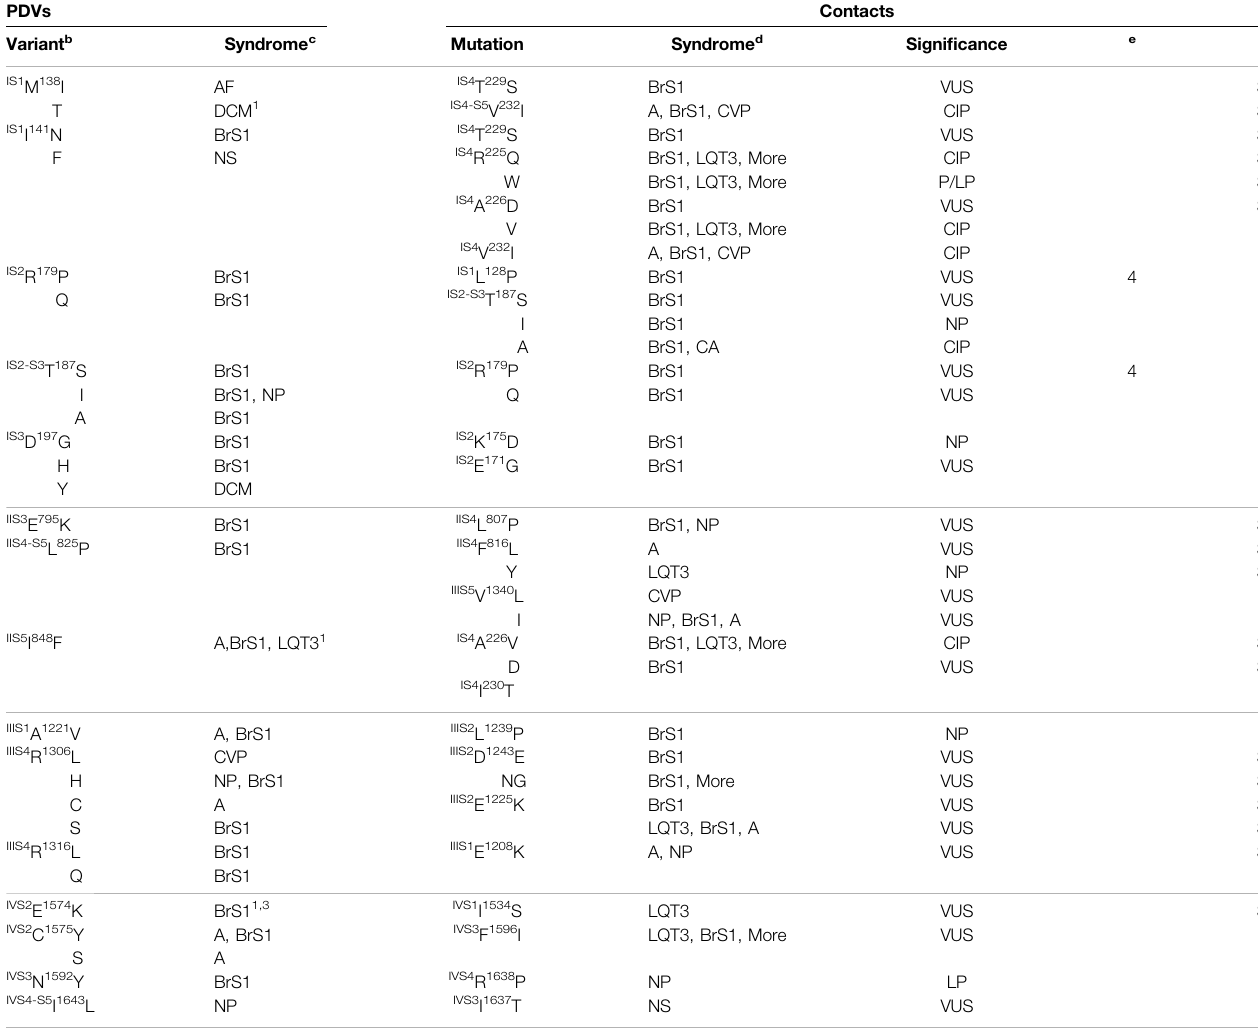
TABLE 4 | PDVs and their contacts in activated VSDs a .